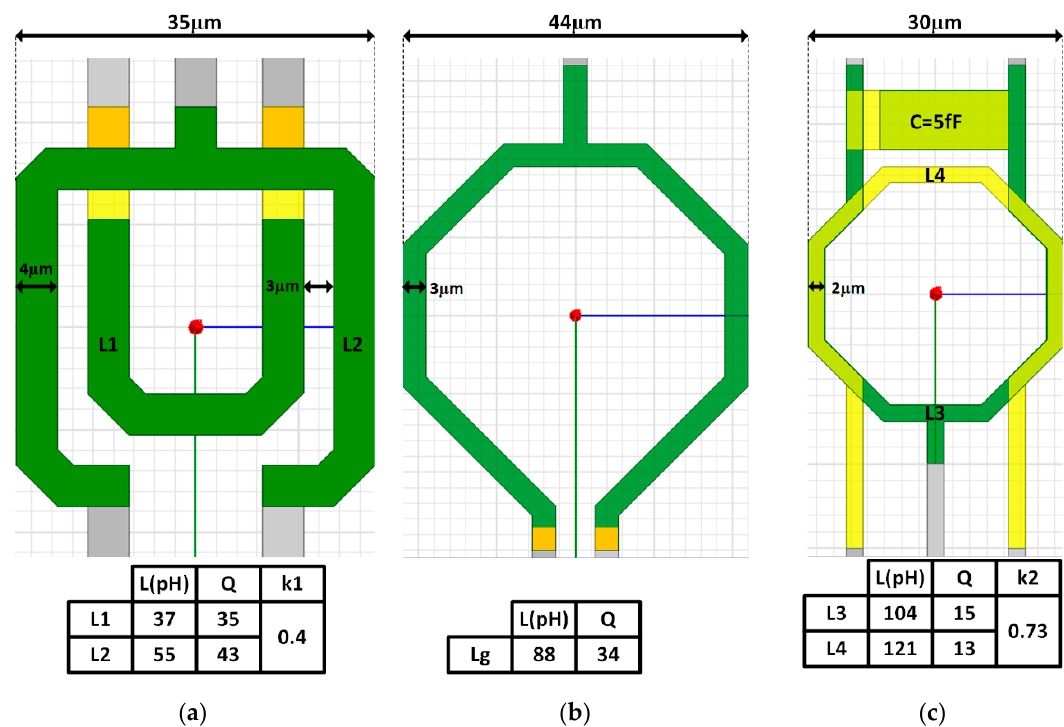
Figure 5. Layout of ( a ) the CLRC transformer; ( b ) the gate inductor L g ; ( c ) the DTS transformer.